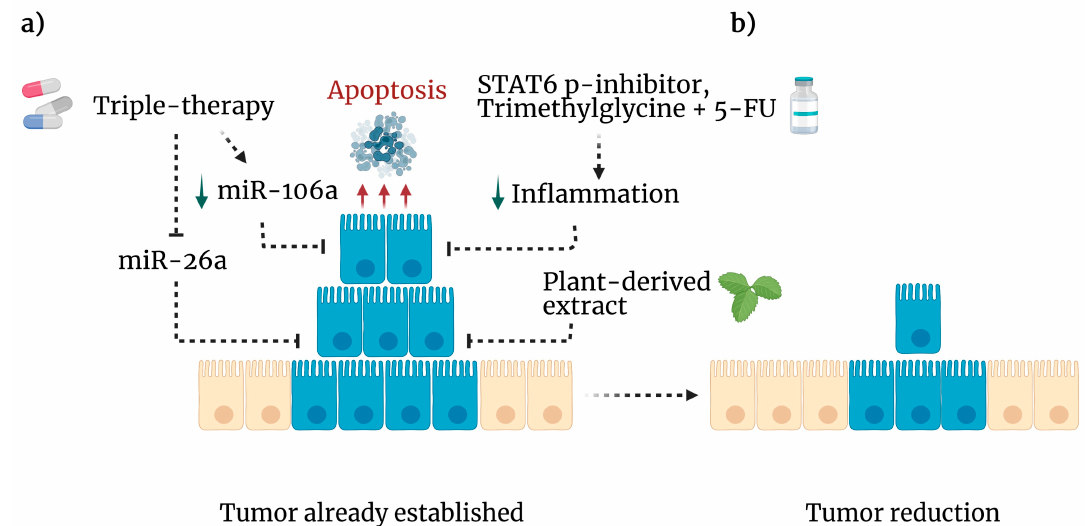
Figure 4. Experimental anticancer therapies. ( a ) If immune surveillance is unsuccessful, cancer cells proliferate to develop a tumor. However, several approaches have been tested to eliminate malignancy. Triple therapy (metformin, sodium oxamate and, doxorubicin) inhibits mIR-26a (dotted line) leading to apoptosis (red arrows) and downregulation of mIR-106a (green arrow). In addition, plant-derived compounds exhibit cytotoxic activity against CRC cell lines. A STAT-6 phosphorylation inhibitor plus trimethylglycine as adjuvant for 5-FU, diminishes inflammation (green arrow) and tumor cell viability. ( b ) As a result, these mechanisms reduced the tumor burden in mice. Created with BioRender.com, accessed on 27 June 2022.